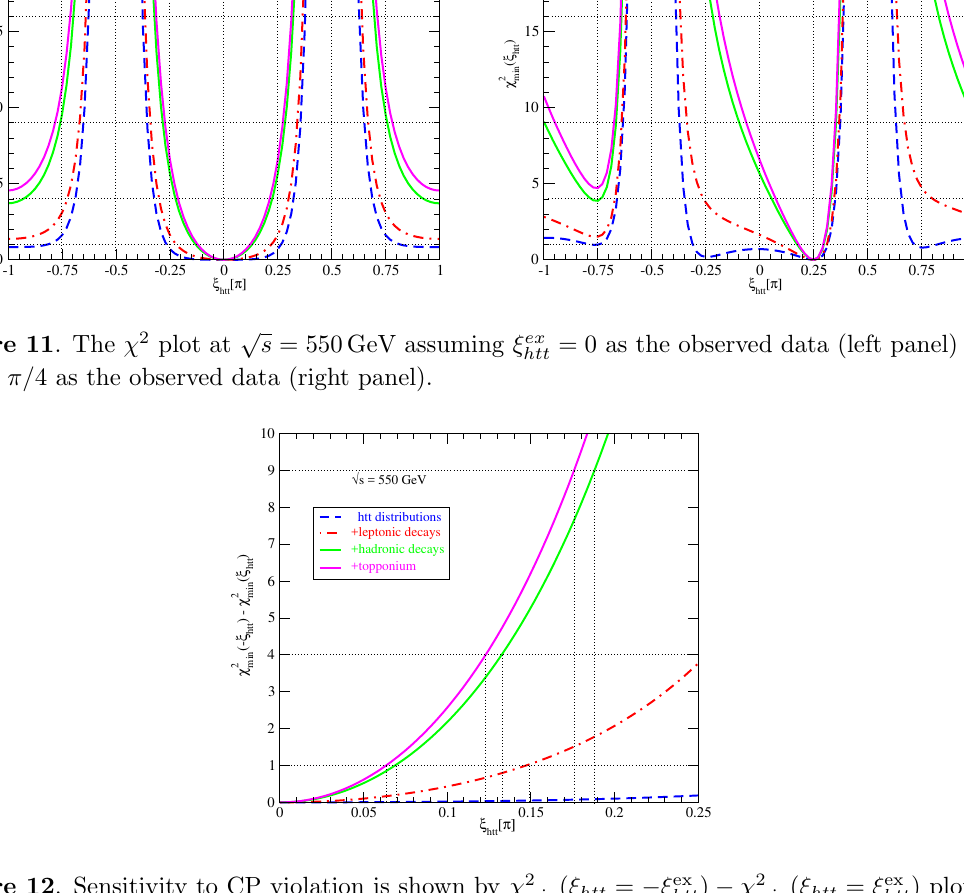
( (cid:24) htt = (cid:24) ex ) (cid:31) 2 ( (cid:24) htt = (cid:24) ex ) plotted min min htt htt (cid:0) (cid:0)